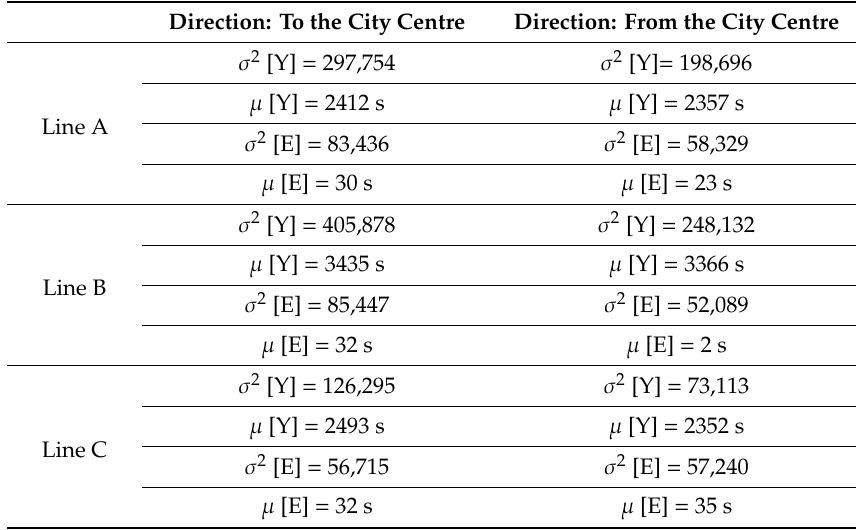
Figure 6. Seasonal components of the analysed bus lines. Table 2. Variance ( σ 2 ) and mean ( µ ) of the observed travel time ( Y ) and the remainder ( E ). Direction: To the City Centre Direction: From the City Centre